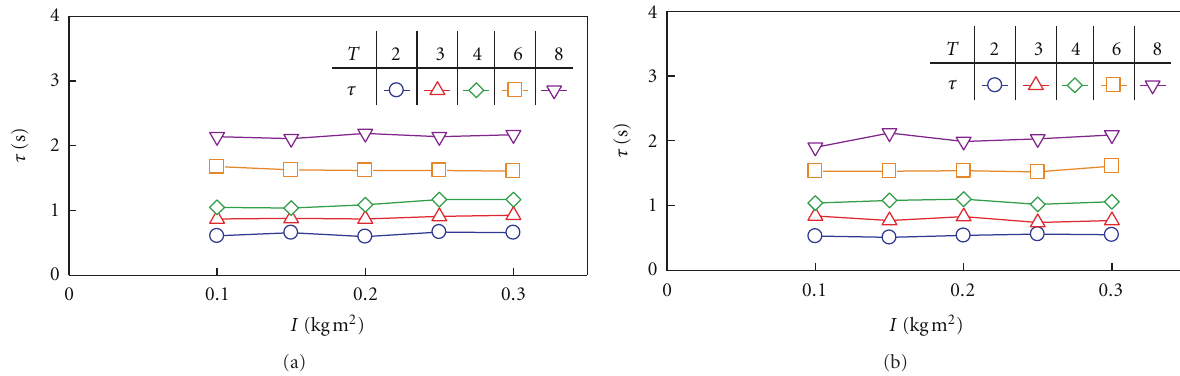
Figure 5: Time delay, τ , for wind amplitude (a) Δ V = 1 and (b) Δ V = 2 m/s.